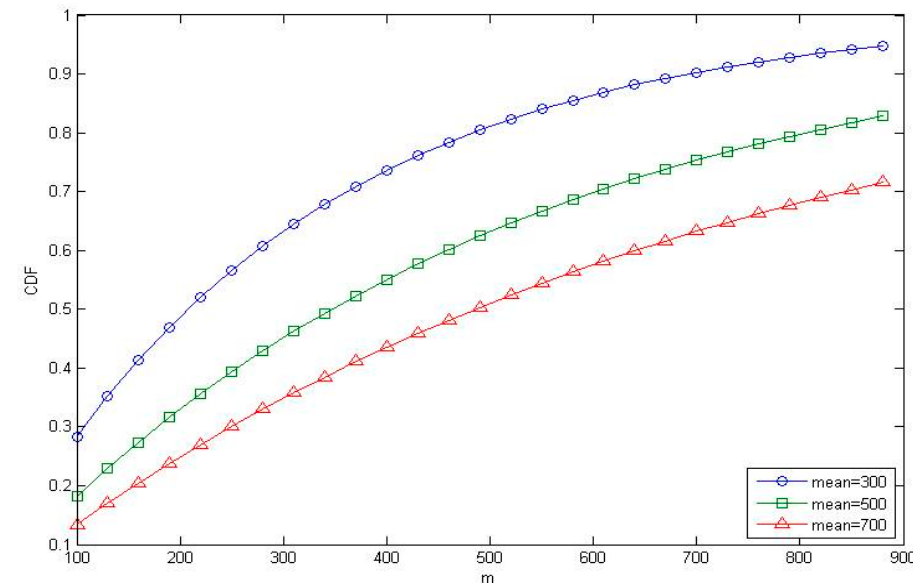
Figure 11. The effect of m on CDF.